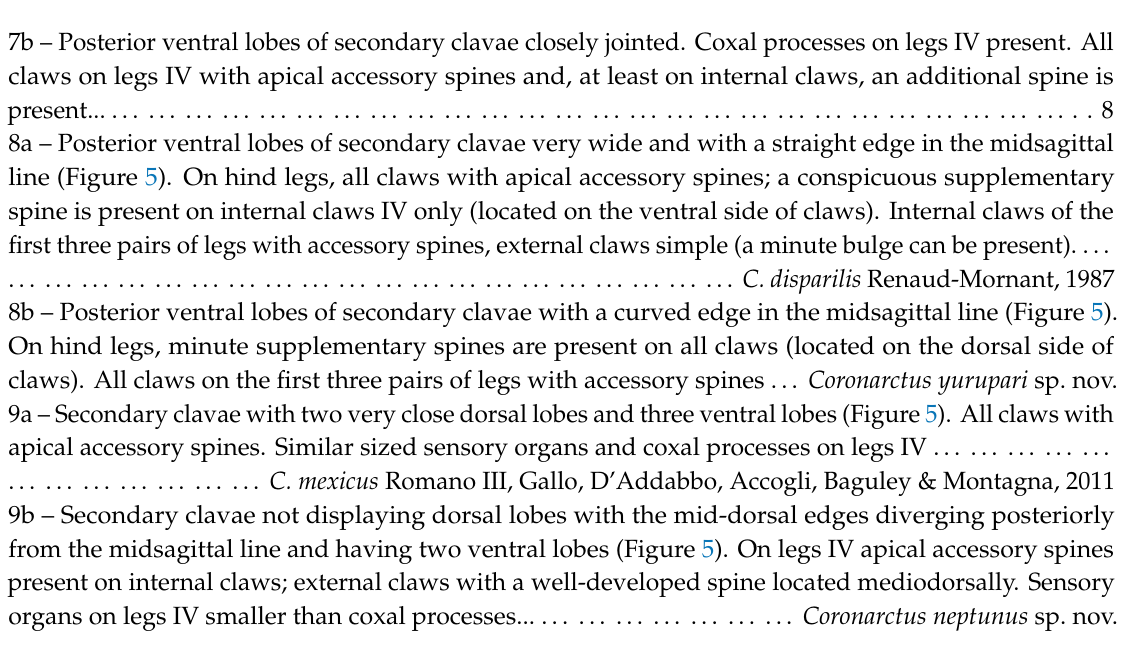
Table S1: Measurements (in µ m) of selected morphological structures of the holotype, allotype and paratypes of Coronarctus dissimilis sp. nov., Table S2: Measurements (in µ m) of selected morphological structures of Coronarctus laubieri Renaud-Mornant, 1987 from Brazil, Table S3: Measurements (in µ m) of selected morphological structures of the holotype, allotype and paratypes of Coronarctus neptunus sp. nov. Table S4: Measurements (in µ m) of selected morphological structures of the holotype, allotype, and paratypes of Coronarctus yurupari sp. nov., Figure S1: Photos of the habitus and some structures of specimens of Coronarctus laubieri Renaud-Mornant, 1987 from Brazil, Figure S2: Drawings of the habitus and some structures of specimens of Coronarctus laubieri Renaud-Mornant, 1987 from